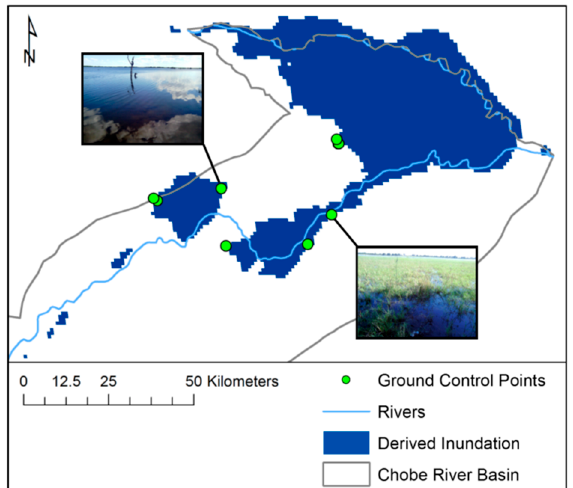
Figure 9. Examples of ground control points taken in the field with their corresponding flooding extent derived from MODIS imagery on the 8-day aggregated 10 June image. All shown GCPs were marked on the furthest extent of flooding in that area. Images shown were taken on location with a Trimble Juno SB device.